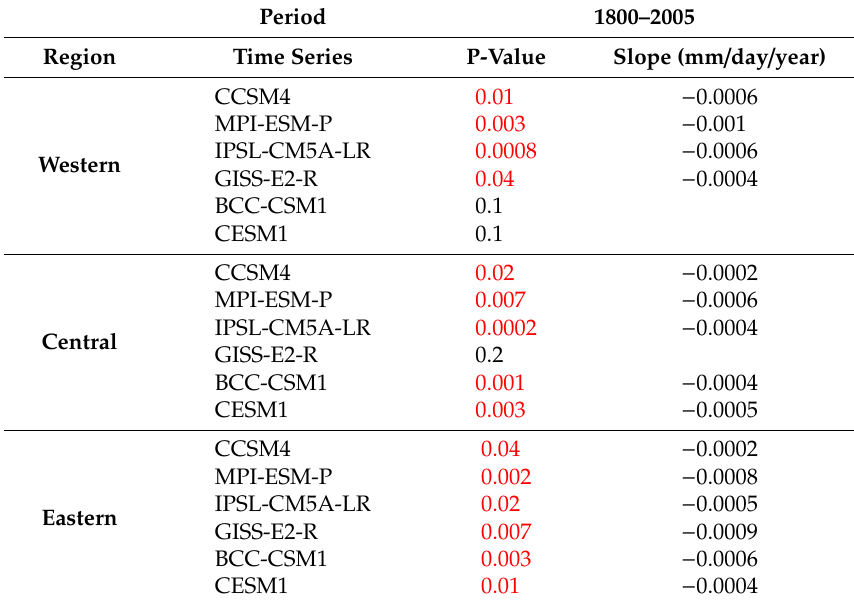
Table 3. Results of modified Mann–Kendall test for precipitation trend detection for six Palaeoclimate Modeling Intercomparison Project (PMIP3) / CMIP5 models over 1800–2005 in the three parts of North Africa. Significant test results ( p -value ≤ 0.05) shown in red.